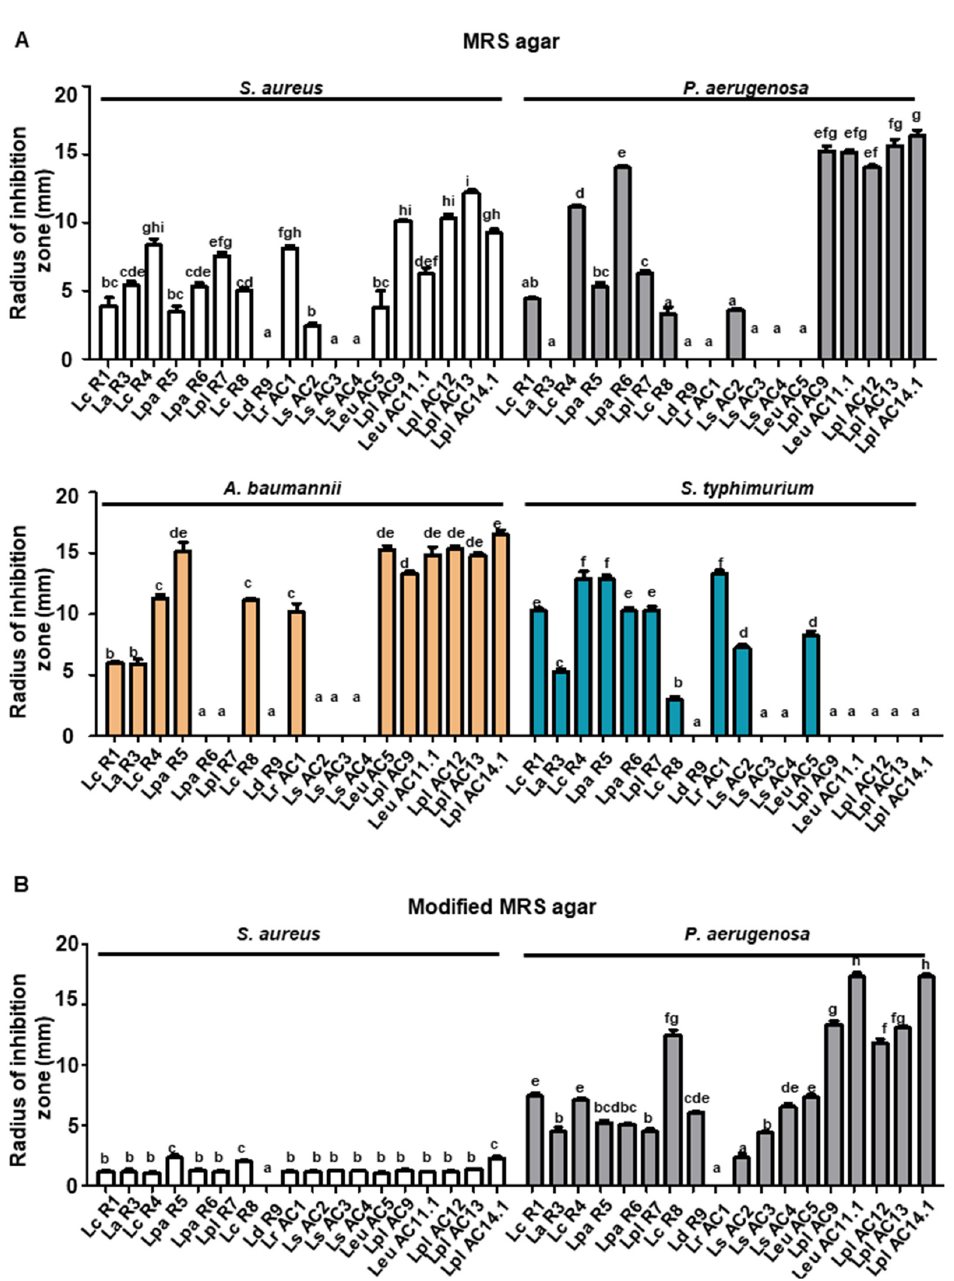
Figure 5. Antimicrobial activity of selected LAB isolates towards different pathogens in MRS agar ( A ) and M-MRS agar ( B ). The radius of inhibition zone was measured in MRS agar plates and modified MRS agar plates. S. aureus , staphylococcus aureus ; A. baumannii , Acinetobacter baumannii ; Salmonella typhimurium , S. typhimurium ; P. aerugenosa , Pseudomonas aerugenosa . Graph bars marked with different letters on top represent statistically significant results. The results were compared by one-way ANOVA and Turkey post hoc test; p < 0.05; n = 2. Lc, L. casei ; La, L. acidophilus ; Lpa, L. paracasei ; Lpl, L. plantarum ; Ld, L. delbrueckii ; Lr, L. rhamnosus ; Ls, L. sakei ; Leu, Leu. mesenteroides